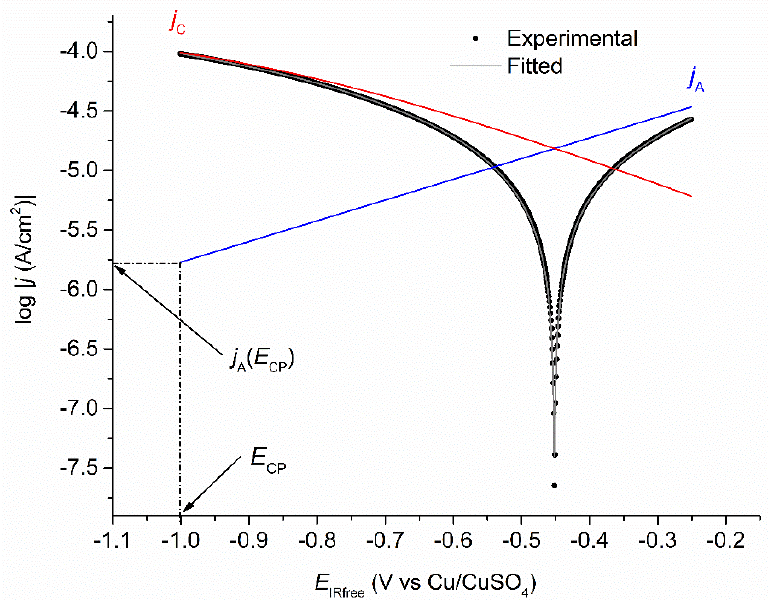
Figure 8. Polarization curves for coupon WE CP1 at day 49: experimental ‐ curve (black dots), fitted ‐ curve (grey full line), anodic (blue line) and cathodic (red line) components drawn using the obtained electrochemical parameters. Table 4. Summary of fitted parameters computed from mathematical modelling for coupon WE CP1 (CSE = copper/copper sulfate electrode).